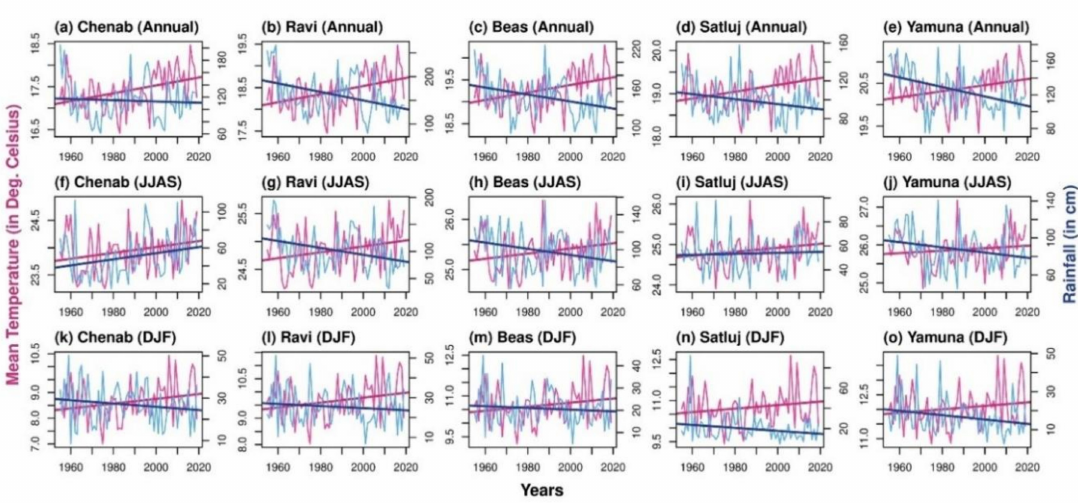
Figure 6. Basin-wise trend of mean temperature and total rainfall for annual, JJAS, and DJF seasons for the 1955–2019 period.